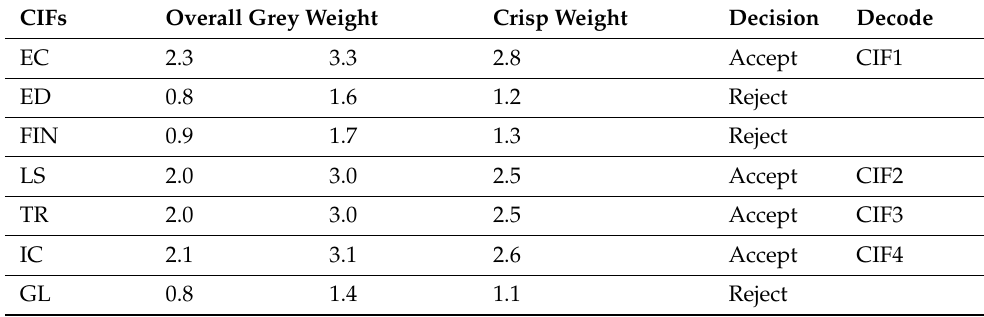
Table 4. Results of the Grey Delphi